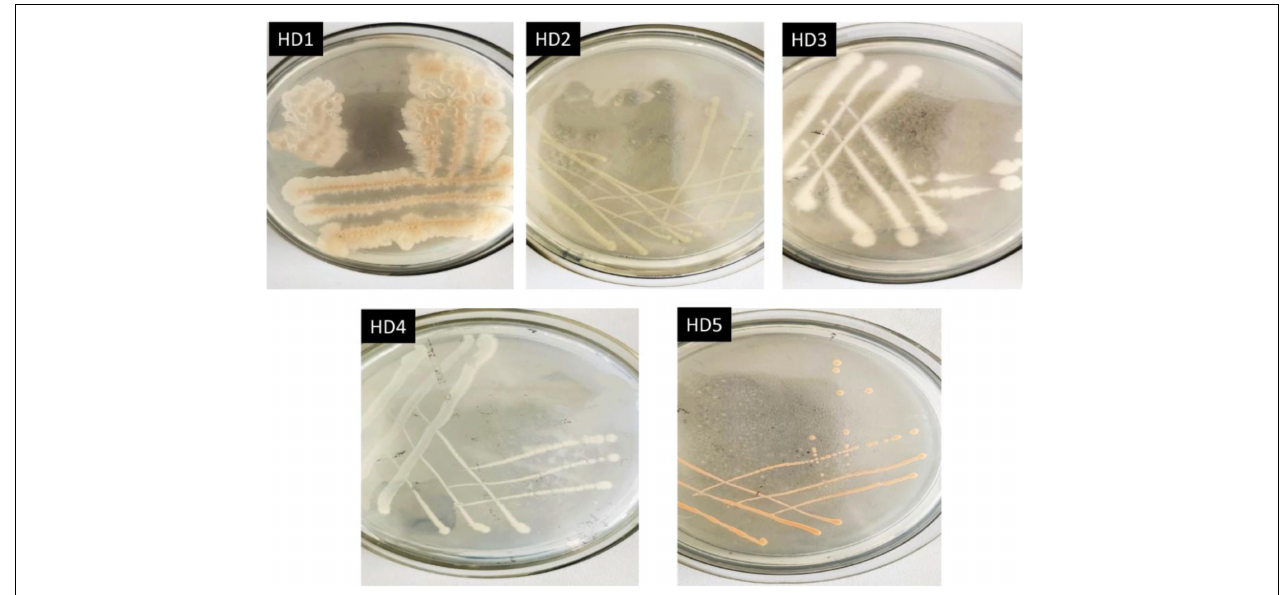
FIGURE 1 | Colony morphologies of 5 OFL-resistant bacterial strains on solid medium.